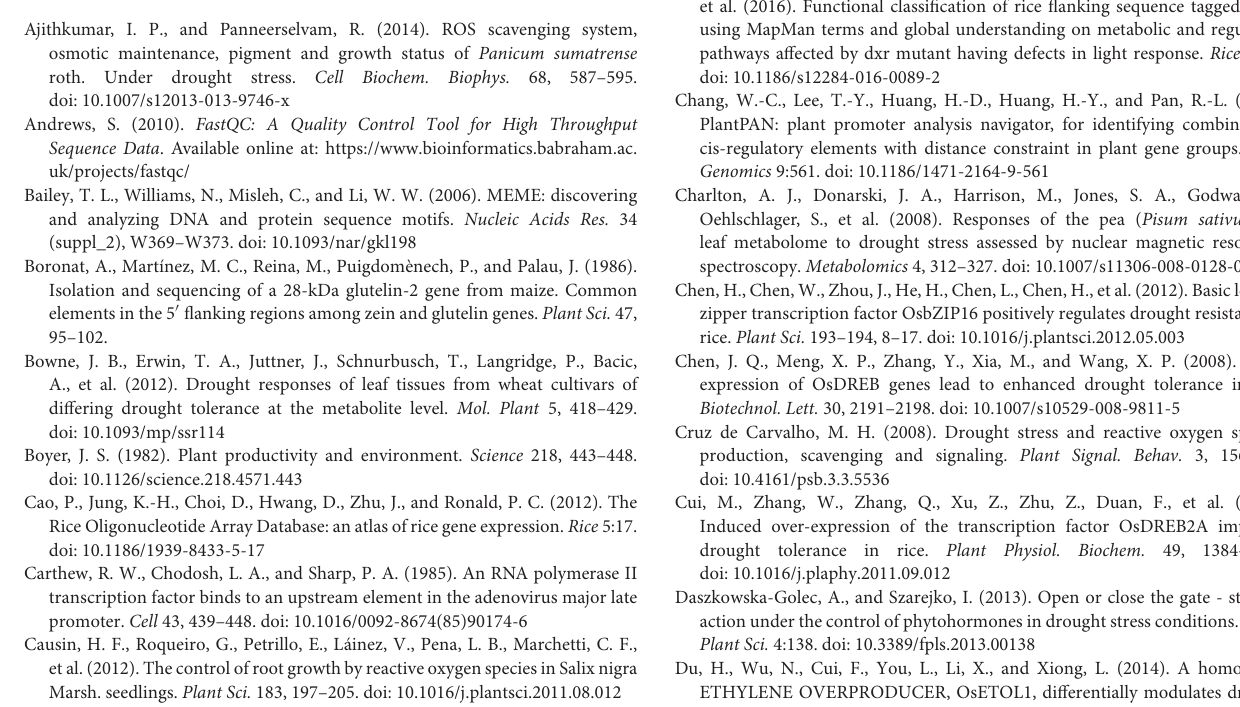
Table S2 | Names and related RNA-Seq data for genes differentially expressed in response to 2 d of water deficiency (WD) vs. well-watered control (C).